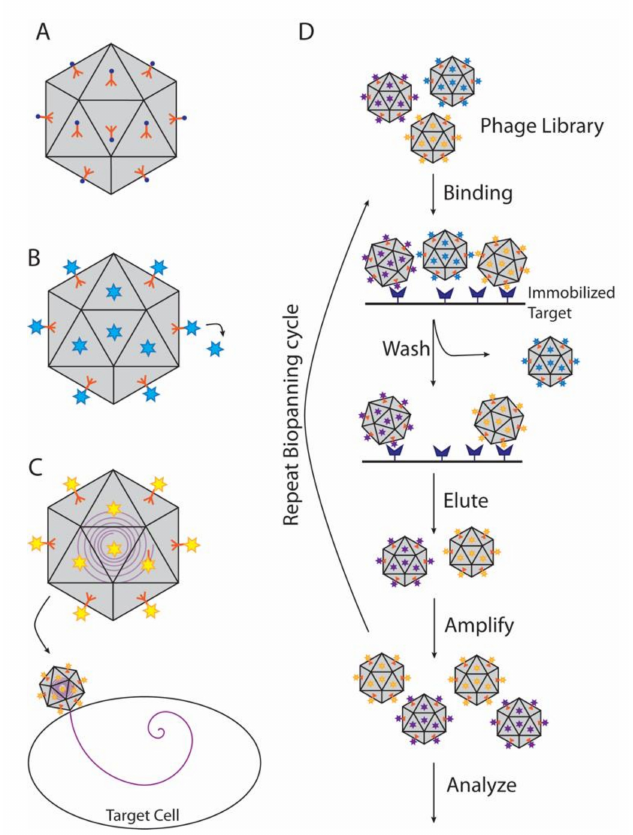
Figure 4. Nanotechnology applications of decoration proteins. Viral nanoparticles (VNPs) are in grey, decoration proteins in orange, and cargo molecules are shown as multi-colored circles and stars. ( A ) Functionalization of VNPs. In this example metal ions are attached to decoration proteins on VNPs, to create magnetic or conductive nanoparticles or nanowires. ( B ) A wide range of molecules can be attached to decoration proteins for phage display or cargo delivery. ( C ) Decoration proteins can be used to target VNPs carrying internal cargos to specific cells. ( D ) Biopanning can be used to find novel